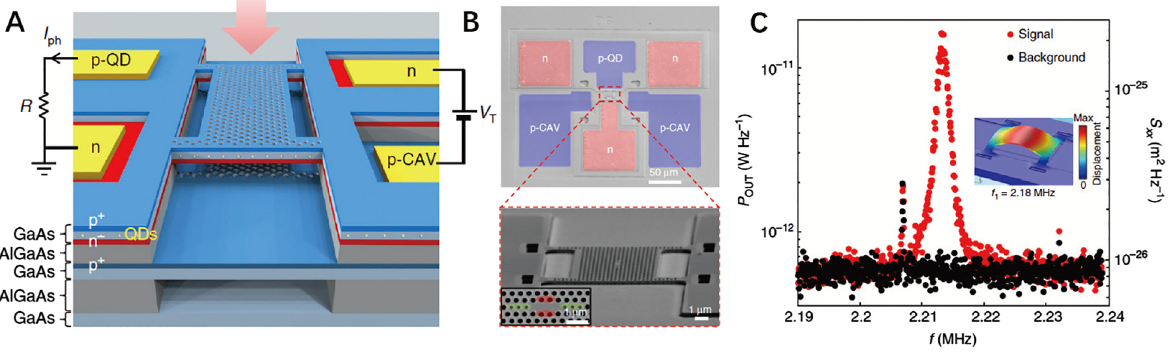
Figure 7: (A) Sketch of the photonic crystal cavity sensing device. (B) False-colored SEM image of a typical device (top view) with contact pads to both sensing and actuation diodes. Bottom: zoom-in SEM image showing the active part of the sensor: a four-arm bridge structure containing a photonic crystal cavity suspended above a fixed photonic crystal membrane. Inset: SEM image of the patterned optical cavity. (C) Electronic spectrum analyzer spectrum of the photocurrent noise where the fundamental mechanical mode is visible in the output power (red dots) and control measurement with laser off (black dots). The right axis displays the calibrated power spectral density of motion. Insert: finite-element simulation of fundamentalmechanical mode at frequency of 2.18 MHz